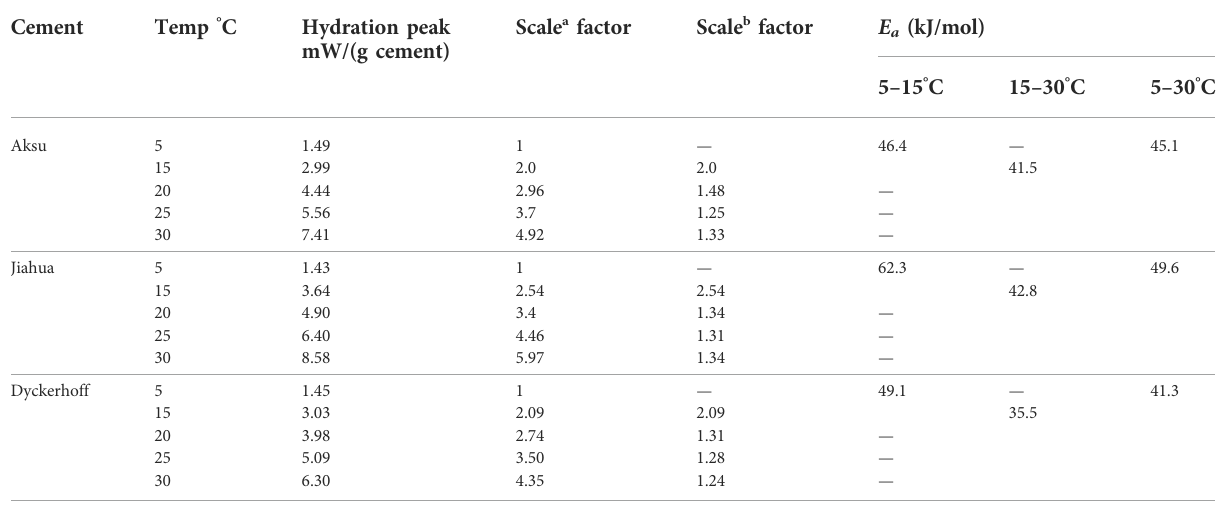
TABLE 3 Model parameters of different cements.